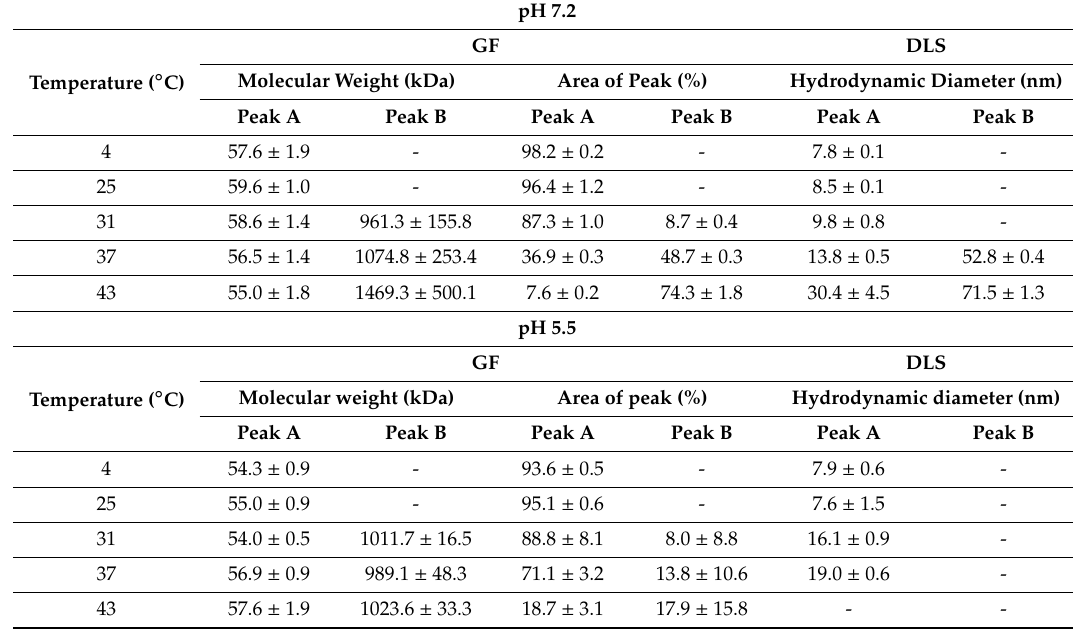
Table 1. Tyrp1tr parameters determined from the gel-filtration chromatography and dynamic light